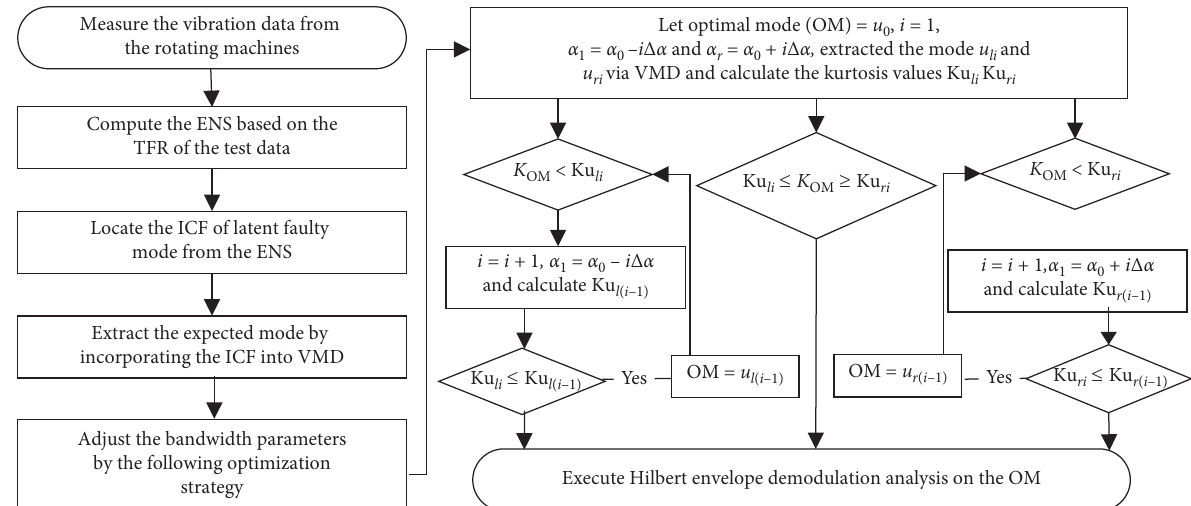
Figure 1: Flow chart of the enhanced VMD method with the guidance of ENS. Table 1: Parameter setting of simulation signal. f T ξ τ 0 re 0